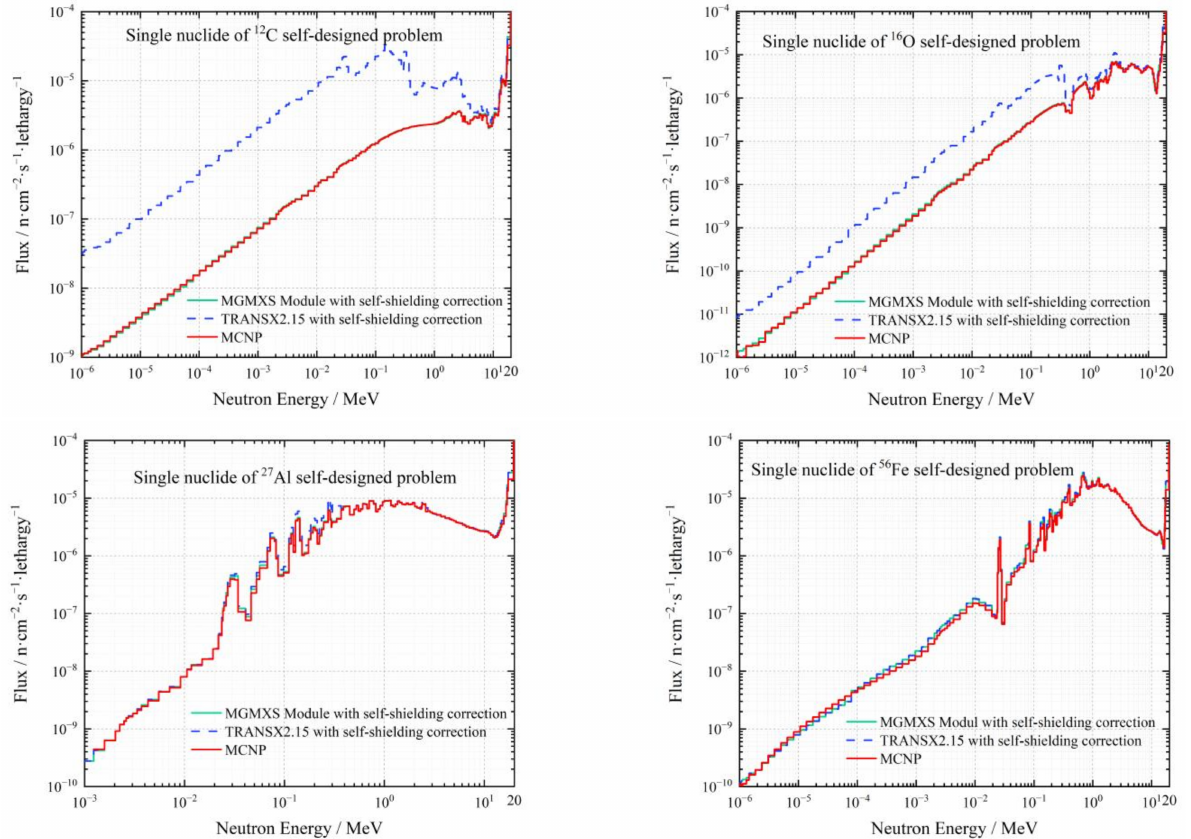
Figure 7. Comparison of self-designed problems with self-shielding